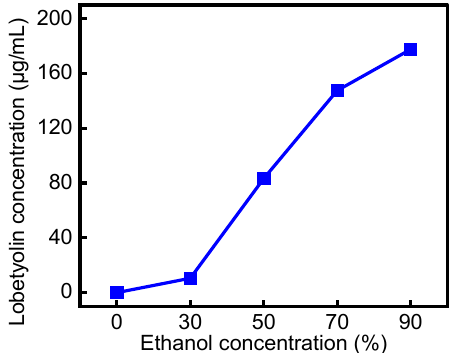
Figure 5. Lobetyolin concentration with varying ethanol concentration.